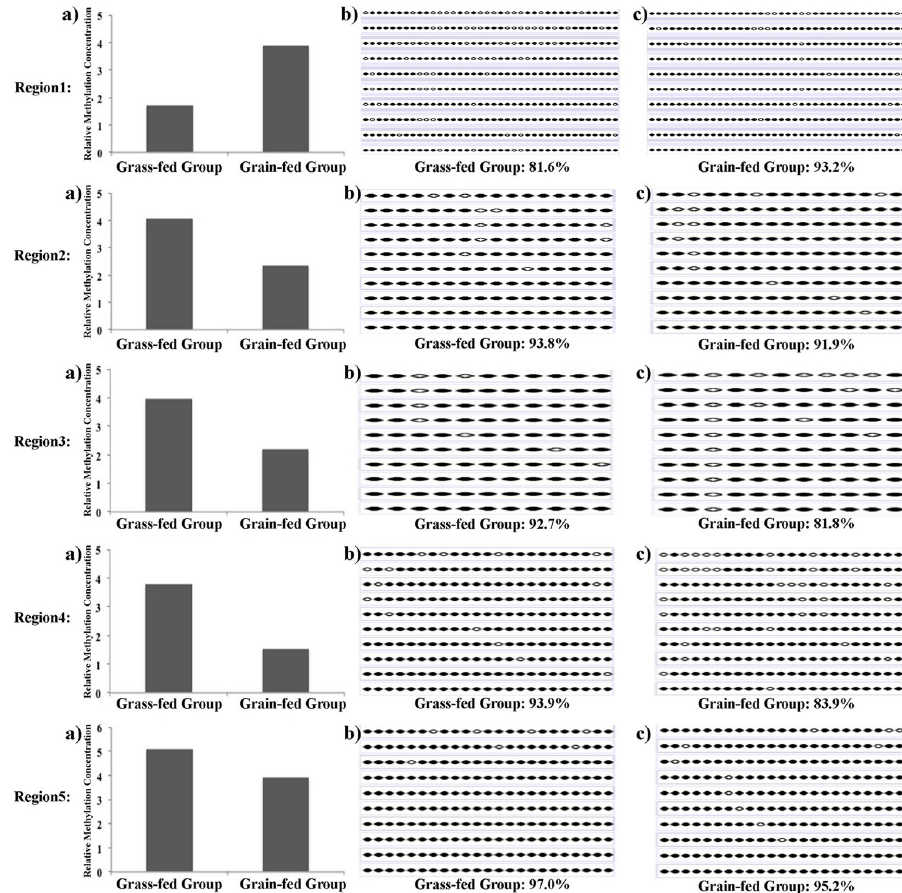
Fig 9. Bisulfite sequencing validation of MBD-Seq results. a) Methylation concentration levels from MBD-seq. b) and c) Bisulfite sequencing results. Each line represents a plasmid sequence and each dot indicates a CpG site. An open circle indicates an unmethylated CpG site and a black dot stands for one methylated CpG site. The methylation level was calculated as the number of methylated CpG sites divided by the total detected CpGs.